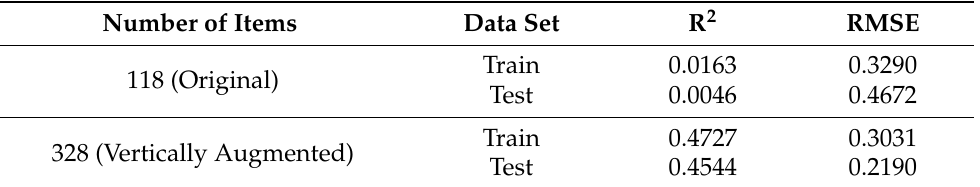
Table 4. Analysis of Ridge regression performance on original and vertically augmented data sets.